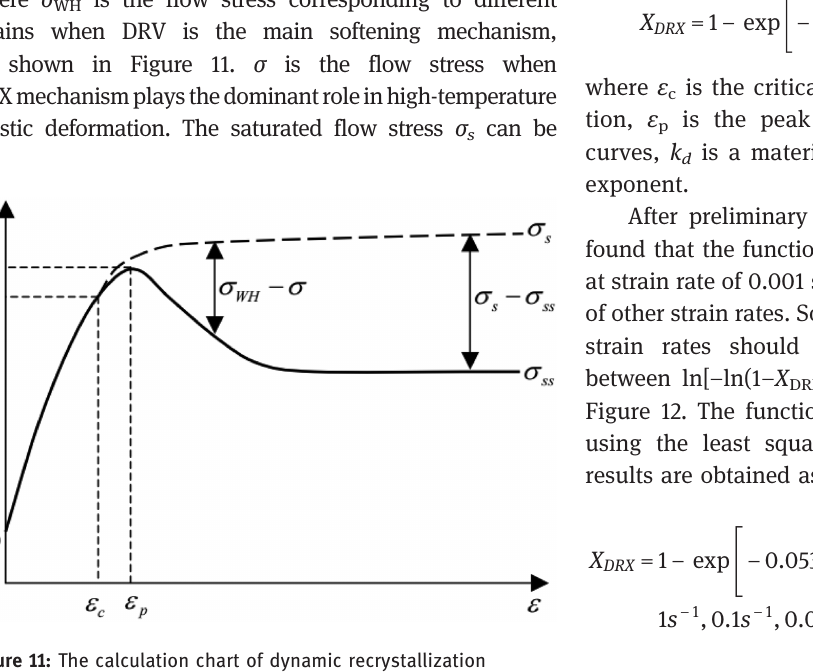
Figure 11: The calculation chart of dynamic recrystallization fraction